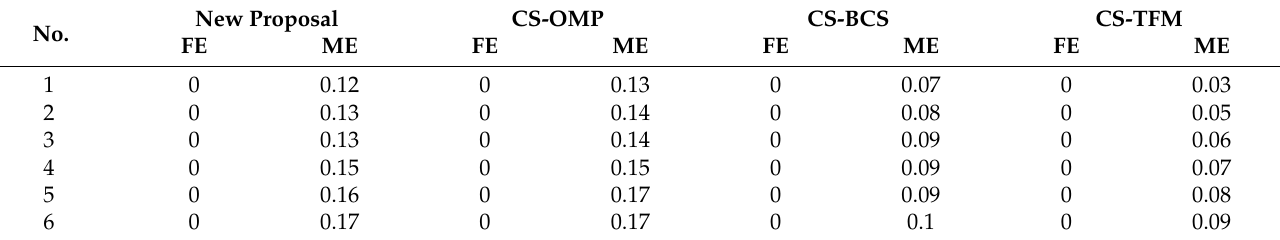
Table 5. Class D test signal amplitude test.